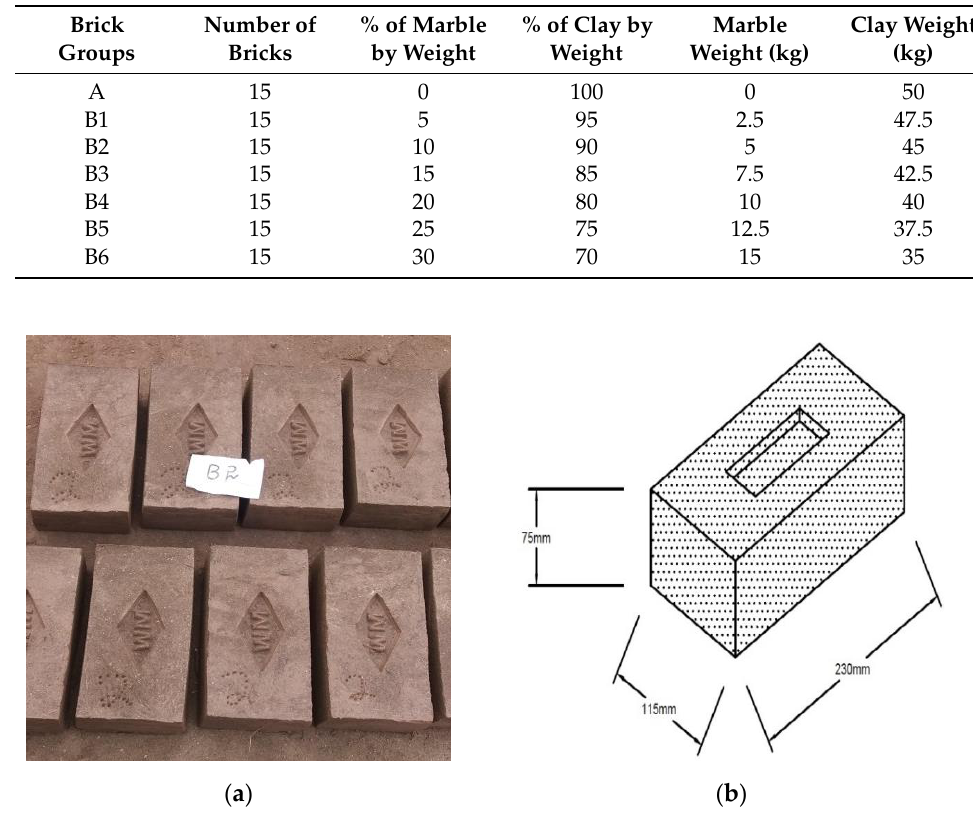
Figure 2. View of: ( a ) prepared marble clay bricks, and ( b ) standard brick size.